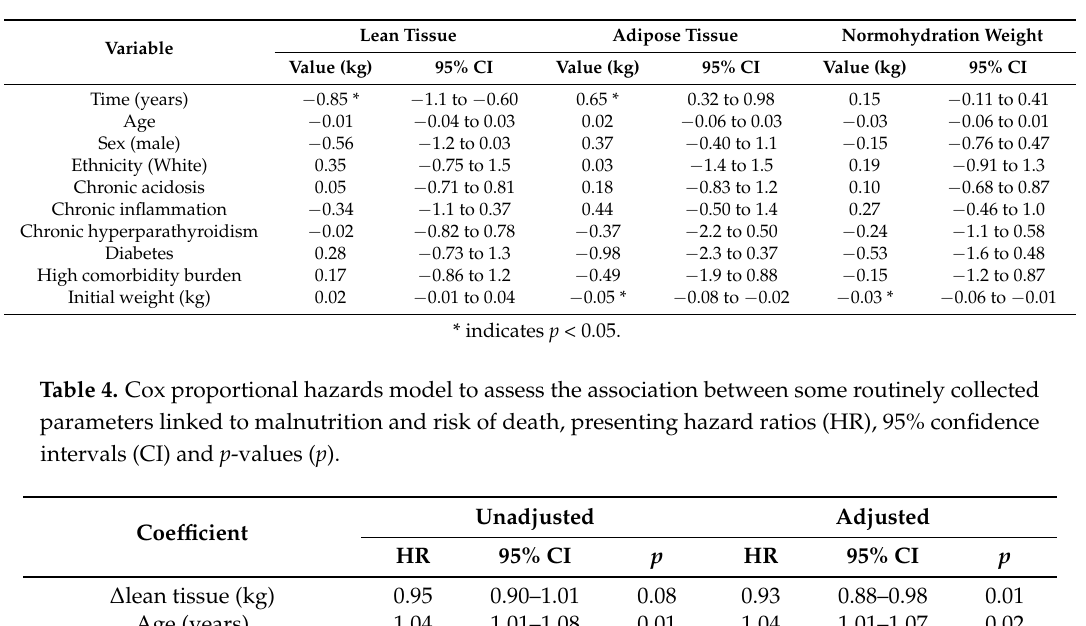
Table 3. Mixed results regression model for the change in body composition over the first two years of HD.